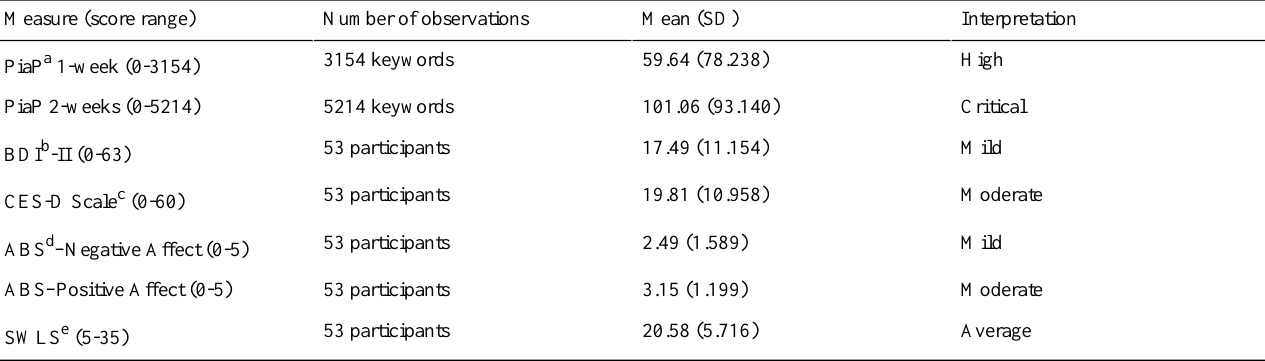
Table 5. Descriptive statistics (Psychologist in a Pocket and psychological tests).